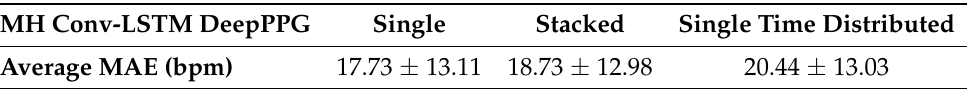
Table 5. Results for different MH Conv-LSTM DeepPPG architectures.